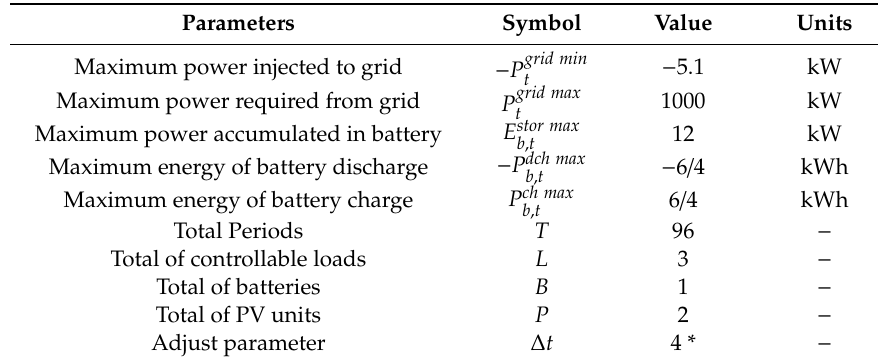
Table 2. Problem input variables.